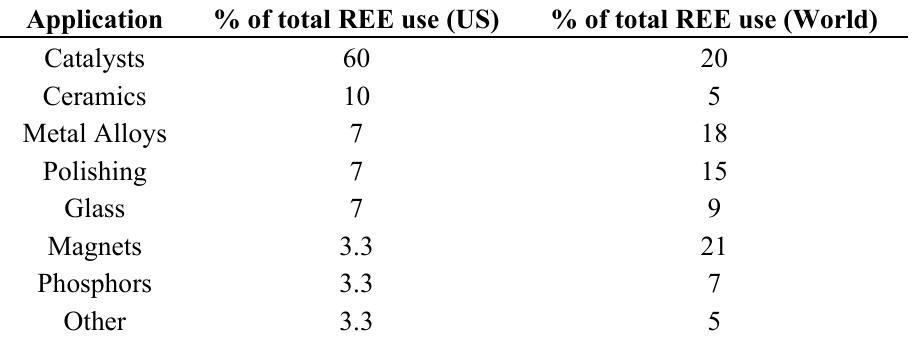
Table 1. Rare earth demand by application for the US and world in 2010